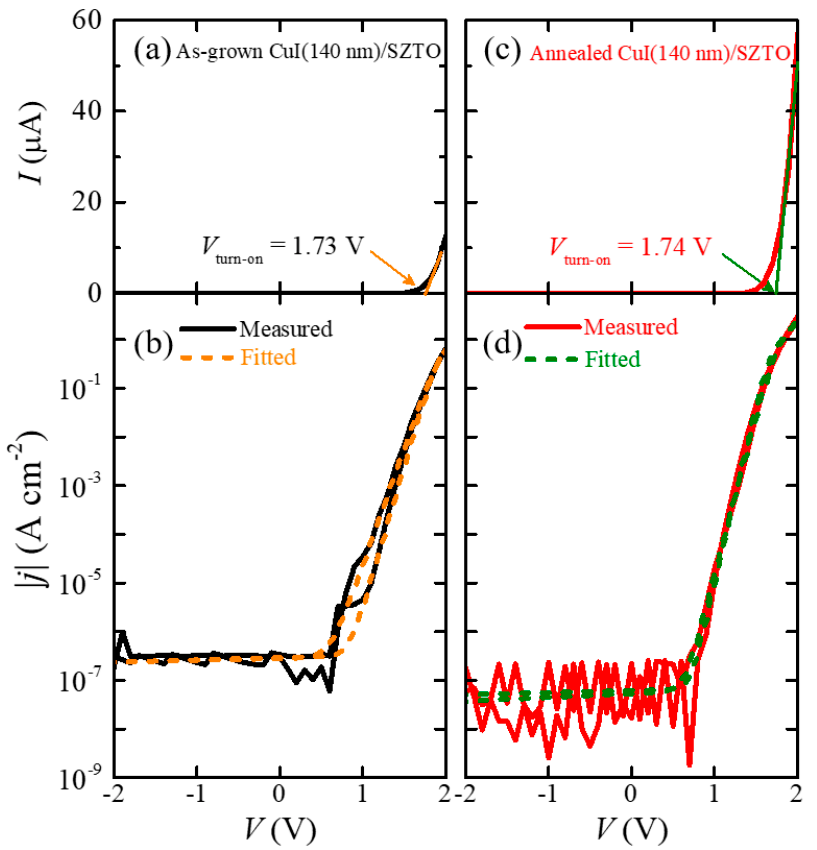
Figure 2. ( a ) The current–voltage I - V curve in a linear scale and ( b ) the current density–voltage |j|-V curve in a semi-log scale of the as-grown CuI (140 nm)/SZTO diode. ( c ) The I - V and ( d ) |j|-V curves of the annealed CuI(140 nm)/SZTO diode. The orange and the green solid lines in the I - V curves represent the linear extrapolation to determine the turn-on voltage of a diode, V turn-on , while the orange and green dashed lines in the |j|-V curves correspond to the diode fitting results based on Equation (1).